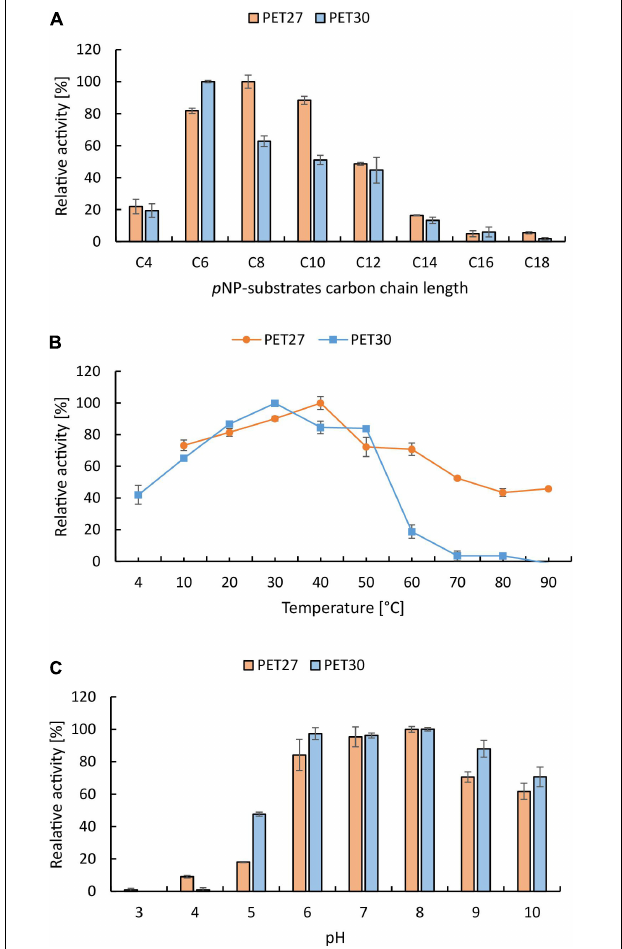
FIGURE 3 | Biochemical characterization of PET27 and PET30 using p NP-substrates. Data represent mean values of at least three independent samples. Substrate preference (A) was tested with p NP-butyrate (-C4) to –stearate (-C18). Temperatures (B) and pH (C) were tested with p NP-octanoate (-C8) for PET27 and with p NP-hexanoate (-C6) for PET30. All assays except B were conducted at 40 ◦ C for PET27 and at 30 ◦ C for PET30. Both enzymes have their highest activity at cold to moderate temperatures (B) and at slightly acidic to alkaline pH (C)